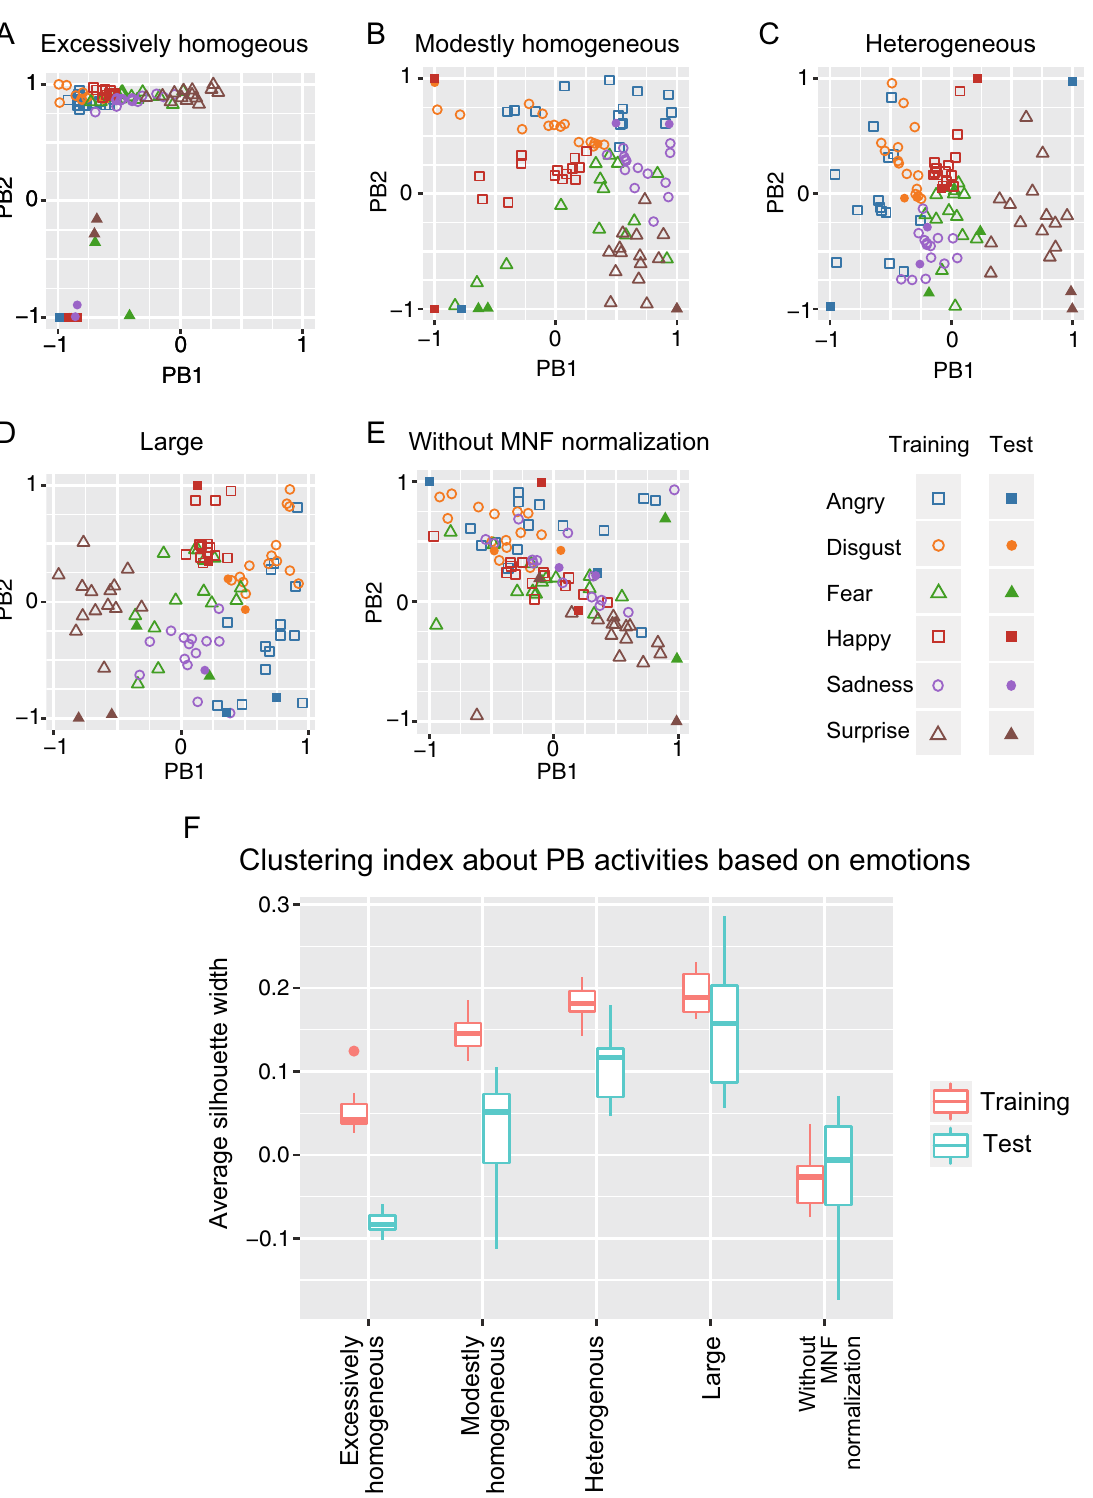
Figure 4. ( A–E ) The optimized PB activities in various networks. The color indicates emotional categories. The outlined symbols express the PBs corresponding to the training sequences, while the filled symbols express those to the test sequences. ( F ) The clustering index of the PB activities based on emotions. The X axis indicates the network models (Table 1) and the Y axis indicates average silhouette widths based on eightfold cross-validation. The silhouette width is a measure of similarity of an object to its own cluster compared to other clusters (detailed in Supplementary Methods). PB parametric bias, MNF normalization; mapping to normal face